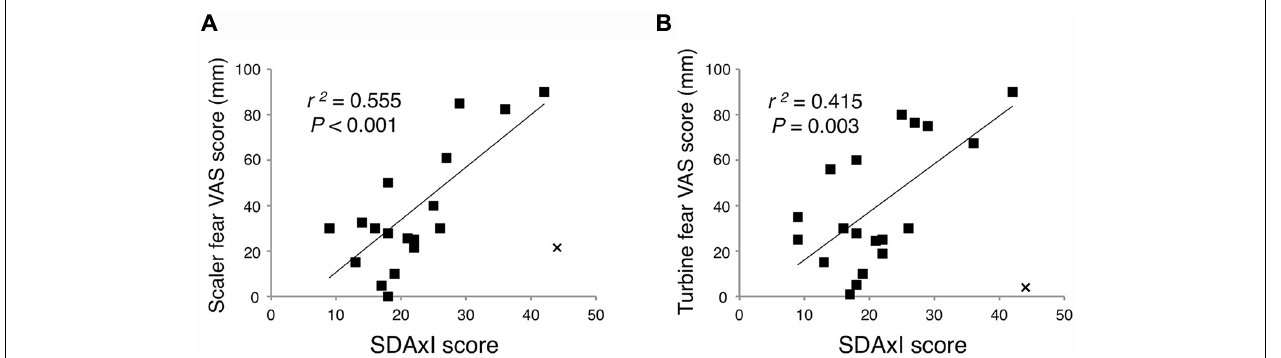
FIGURE 3 | Associations of short version of Dental Anxiety Inventory (SDAxI) score with dental fear visual analog scale (VAS) scores of scaler or turbine video. (A) SDAxI and scaler VAS scores were positively correlated ( n = 19). (B) SDAxI and turbine VAS scores were positively correlated ( n = 19). For both correlations, we excluded one outlier that corresponded to the same participant (data point “x”). Both data had Cook’s distances more than three standard deviations from the mean Cook’s distance and were thus